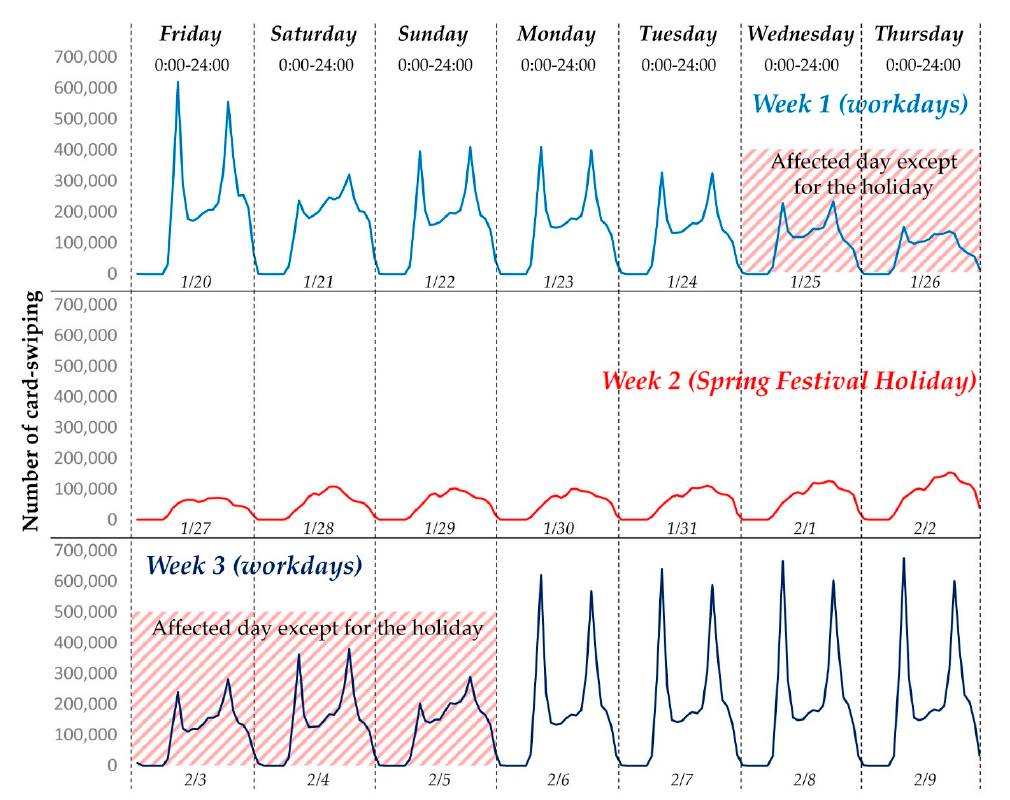
Figure 10. The hourly number of passengers on each day of the 3 weeks.